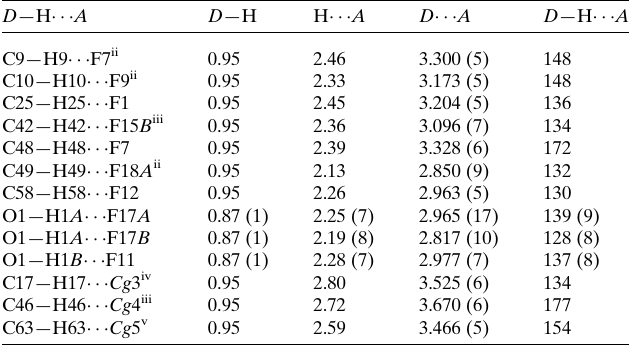
Table 2 Hydrogen-bond geometry (A˚ , (cid:4) ). Cg 1, Cg 2, Cg 3 and Cg 4 are the centroids of atoms C19–C24, C67–C72, C37– C42 and N5/C49–C53, respectively.